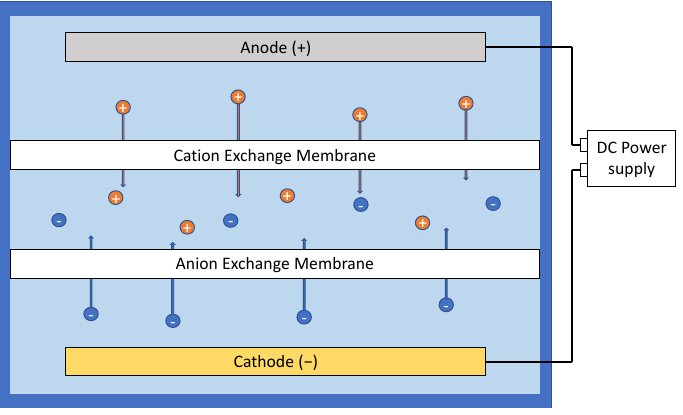
Figure 7. Electrodialysis under a direct current